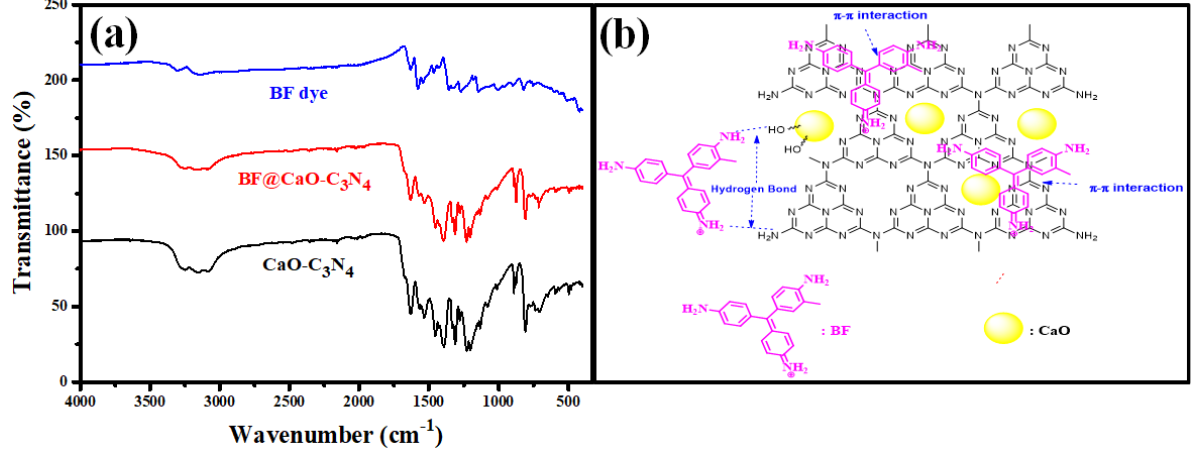
Figure 10. ( a ) FTIR spectra of BF, CaO-g-C 3 N 4 and CaO-g-C 3 N 4 @BF and ( b ) Possible adsorption mechanism of BF dyes onto CaO-g-C 3 N 4 .